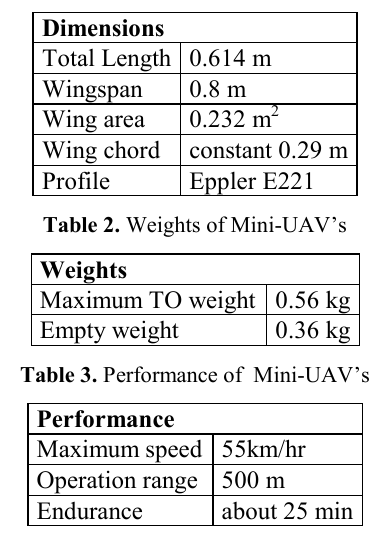
Table 4. Manufacture of